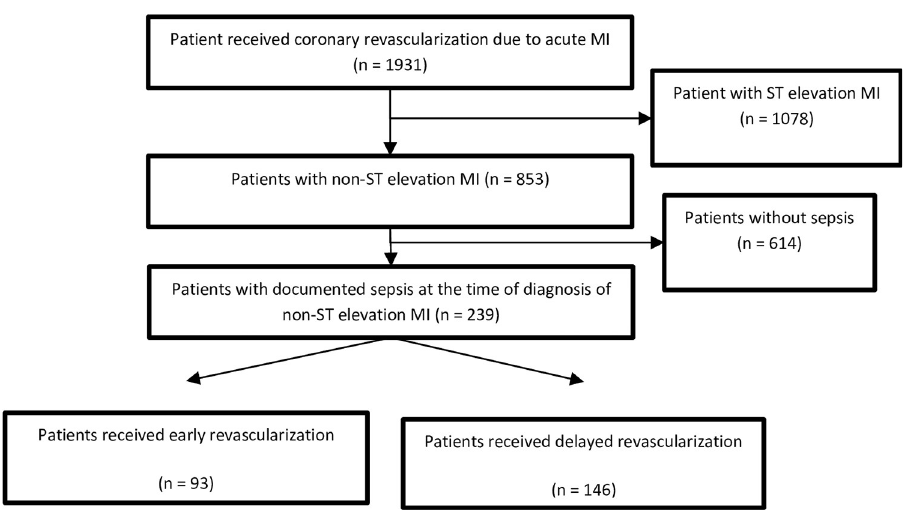
Fig 1. Flowchart of patient